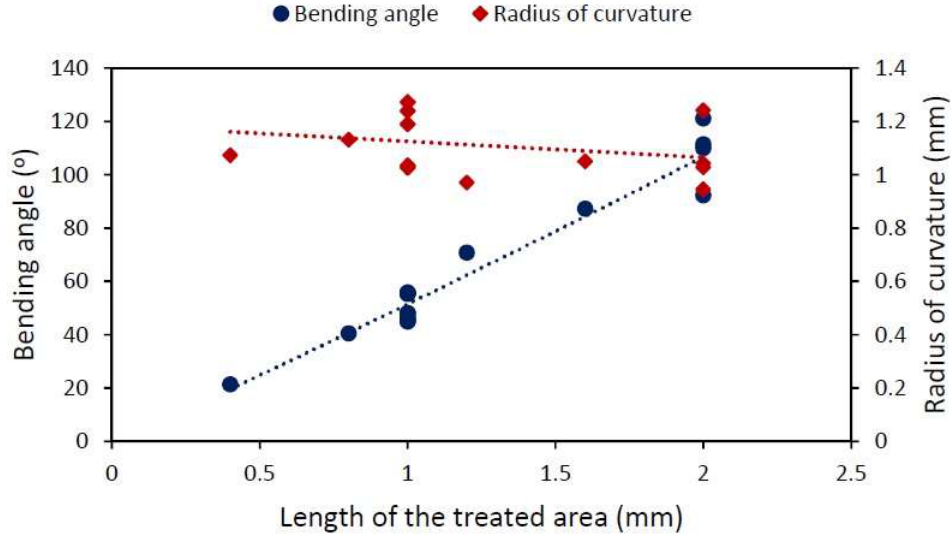
Figure 5. Bending angle (round points) and radius of curvature (diamonds) dependence on the length of the treated area ranging from 0.4 to 2 mm. E = 115 µ J, P y = 20 µ m, P x = 1 µ m, f = 1 kHz and v = 1 mm . The lines are visual guides.